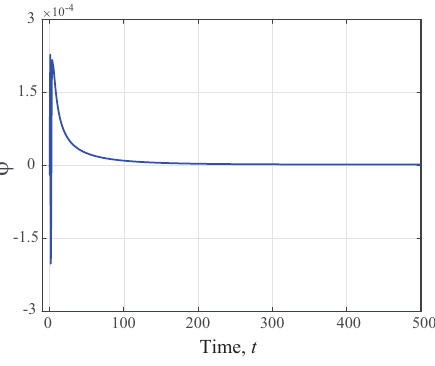
Figure 5. Plant and model reference outputs x p